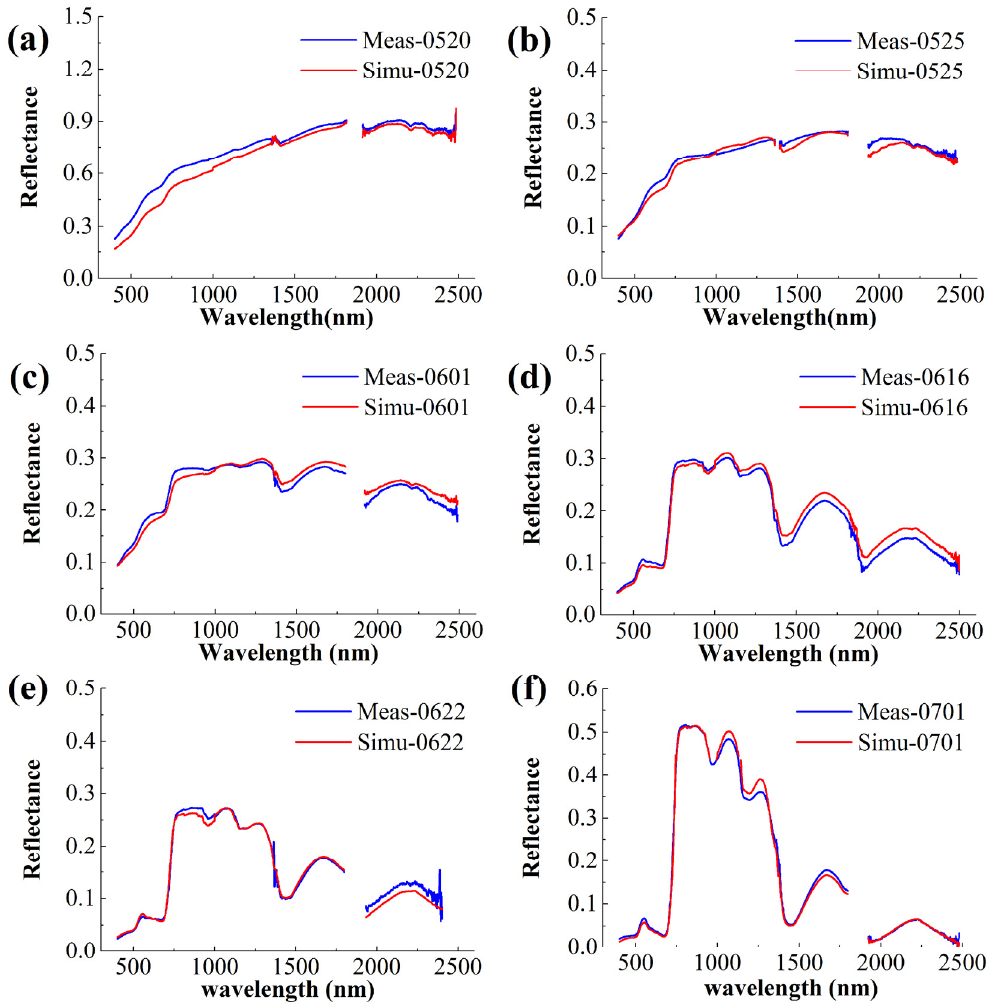
Figure 9. Comparison of the sum of the reflectance simulated by the row model and field data at the wavelength in the vertical viewing direction on ( a ) 20 May, ( b ) 25 May, ( c ) 1 June, ( d ) 16 June, ( e ) 22 June, and ( f ) 1 July. Here, the noise in the water vapor absorption was removed. 2.